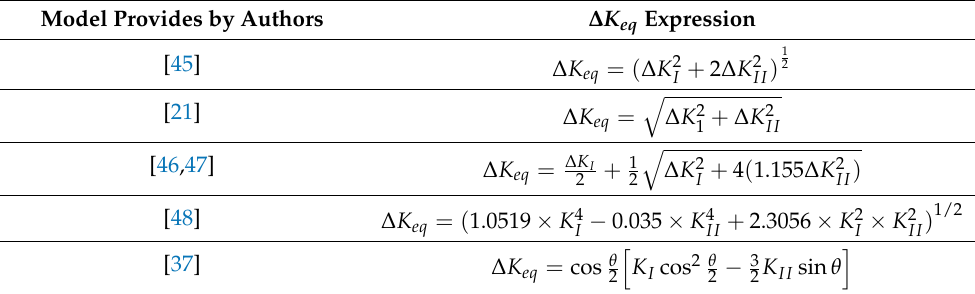
Table 1. Commonly applied ∆ K eq